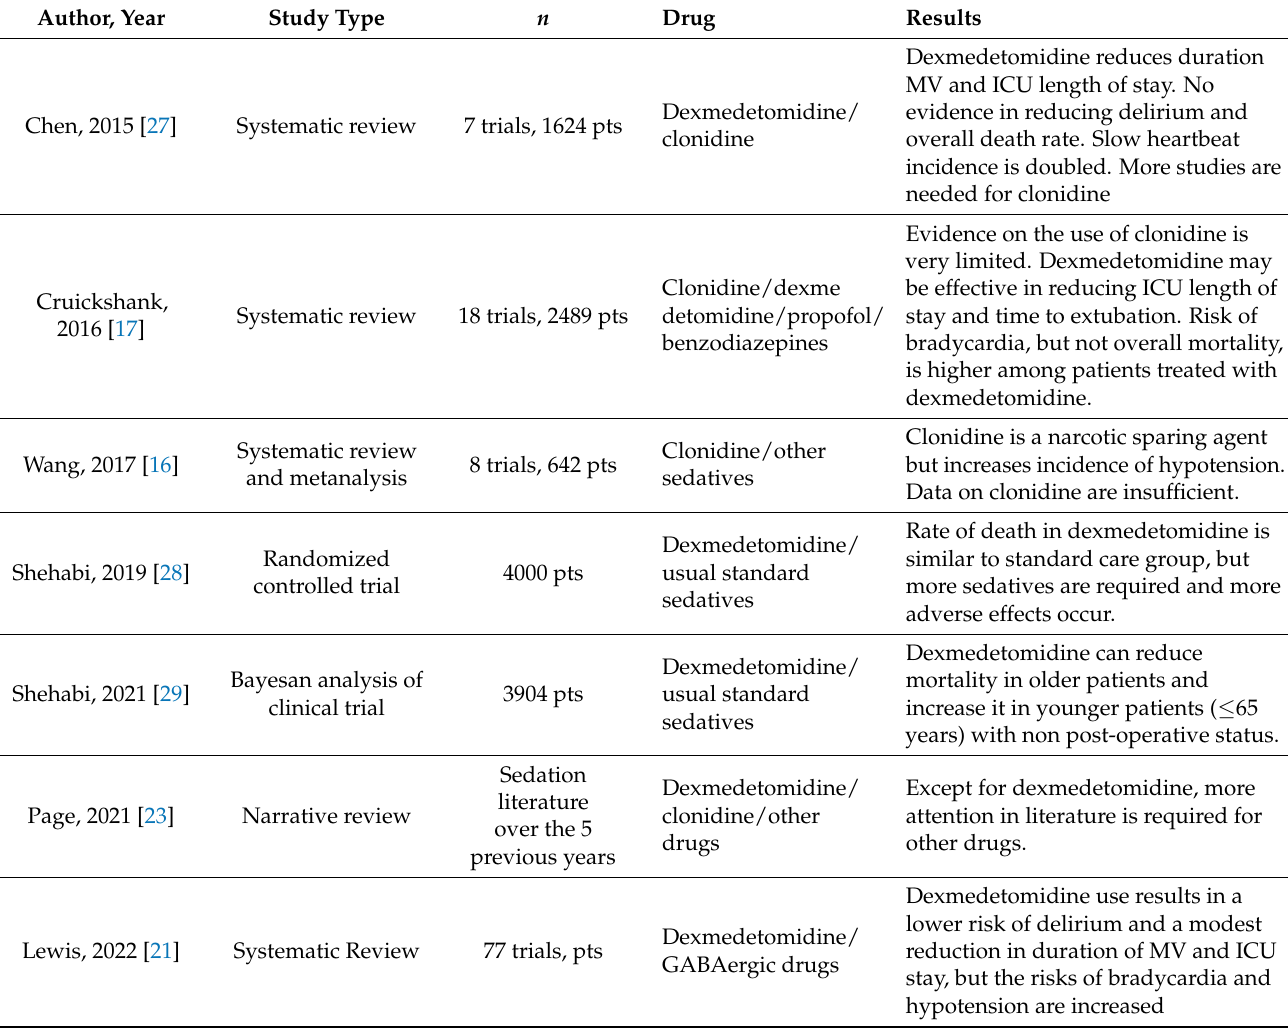
Table 1. Summary of some studies on sedation in mechanically ventilated